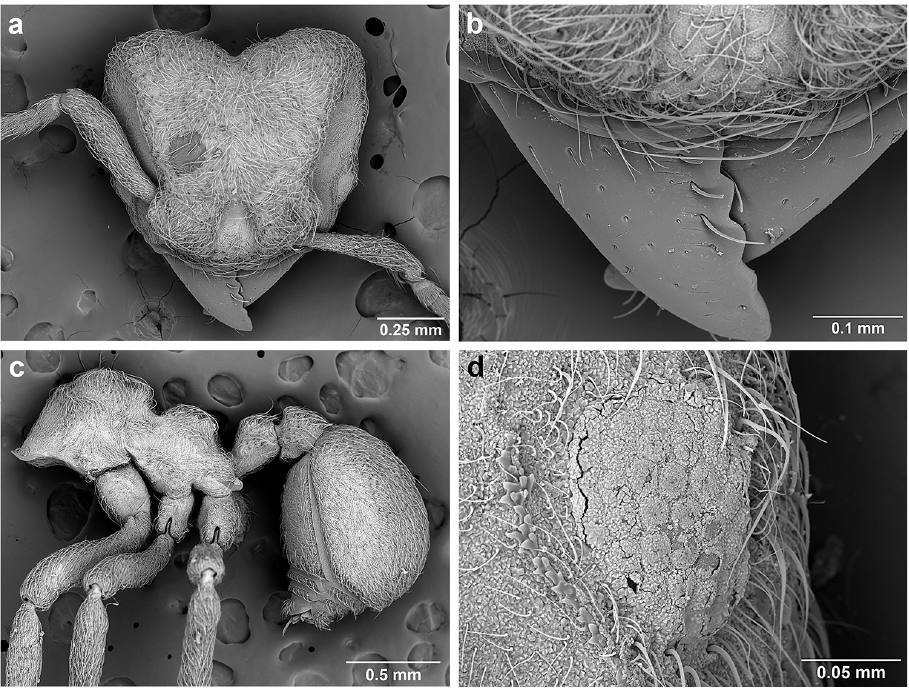
Figure 44. S. opacus worker (USNMENT01125331), SEM images. a Head, full-face view b mandibles c mesosoma and metasoma, lateral view d